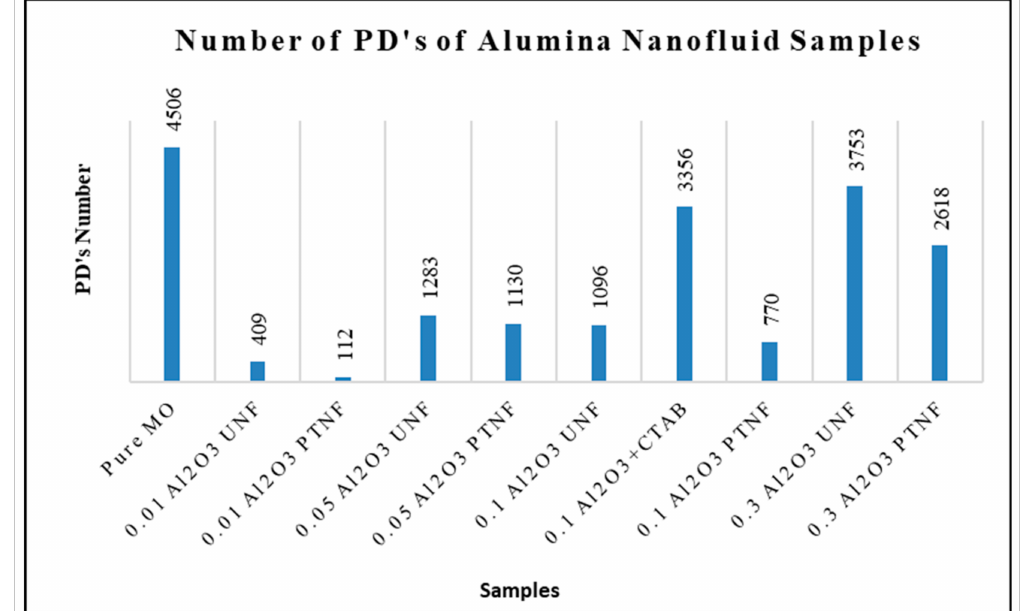
Figure 13. The number of PDs of all alumina nanofluid